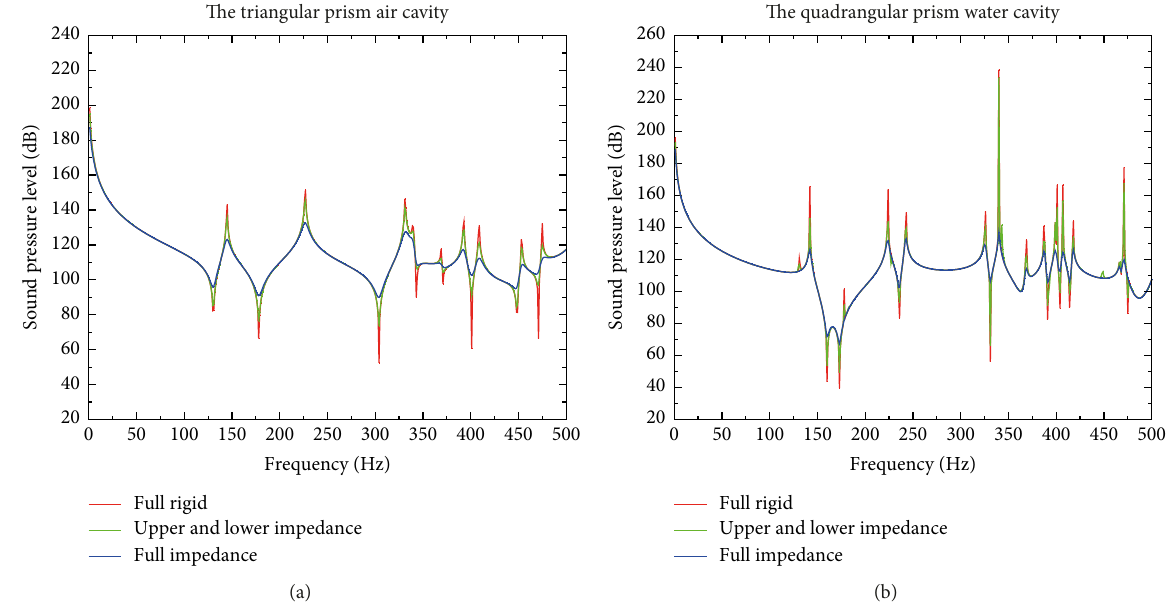
Figure 13: Acoustic pressure response of prismatic air cavities with various impedance walls under the unit point sound source